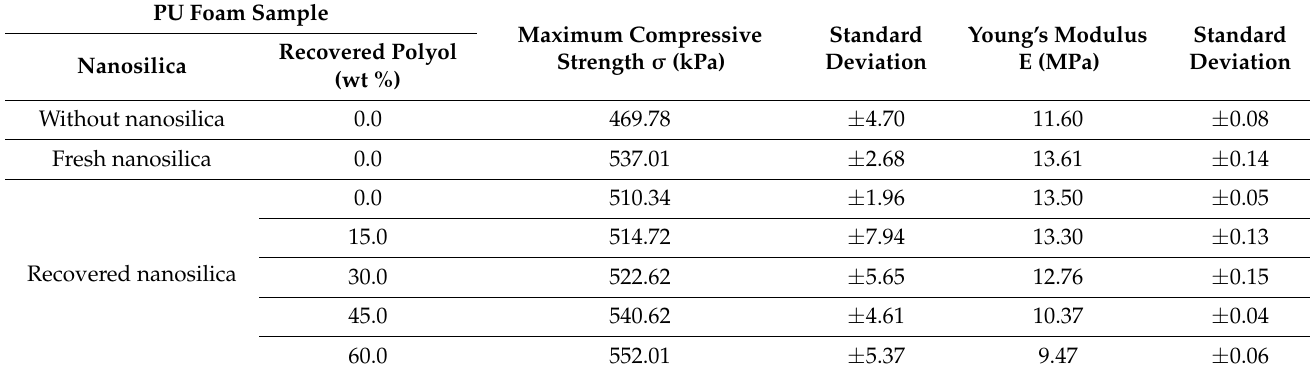
Table 7. Maximum compressive strength and Young’s modulus depending on the recovered polyol percentage replacing the raw rigid polyol, employing fresh or recovered nanosilica or without nanosilica. PU Foam